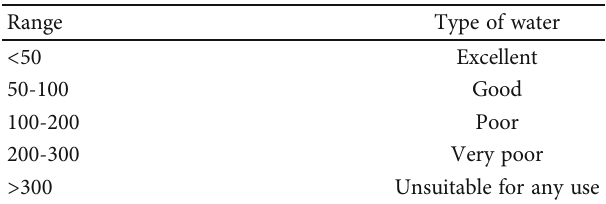
Table 3: Water quality classi fi cation.